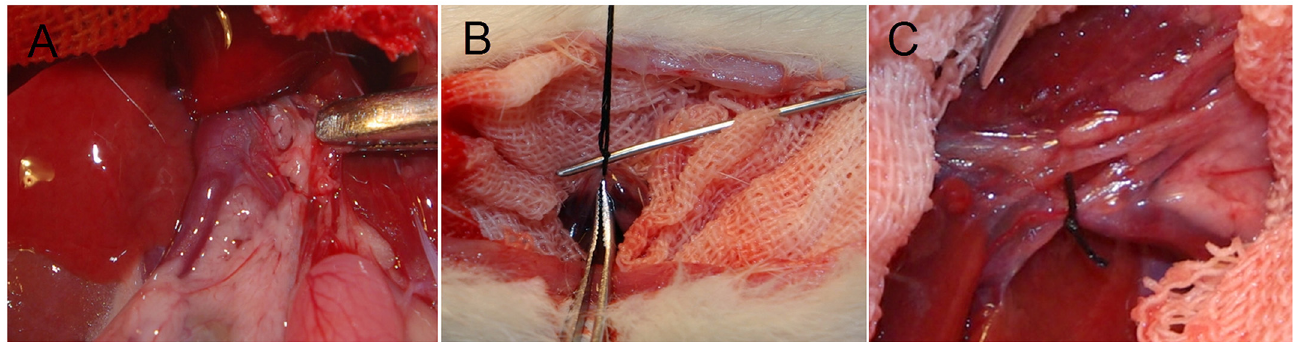
Fig 2. Induction of portal hypertension. (A) The portal vein was freed from the surrounding tissues. (B) A ligature (silk 4 – 0) was placed around a 21-gauge blunt-tipped needle lying alongside the portal vein. (C) Removal of the needle yielded a calibrated stenosis of the portal vein.